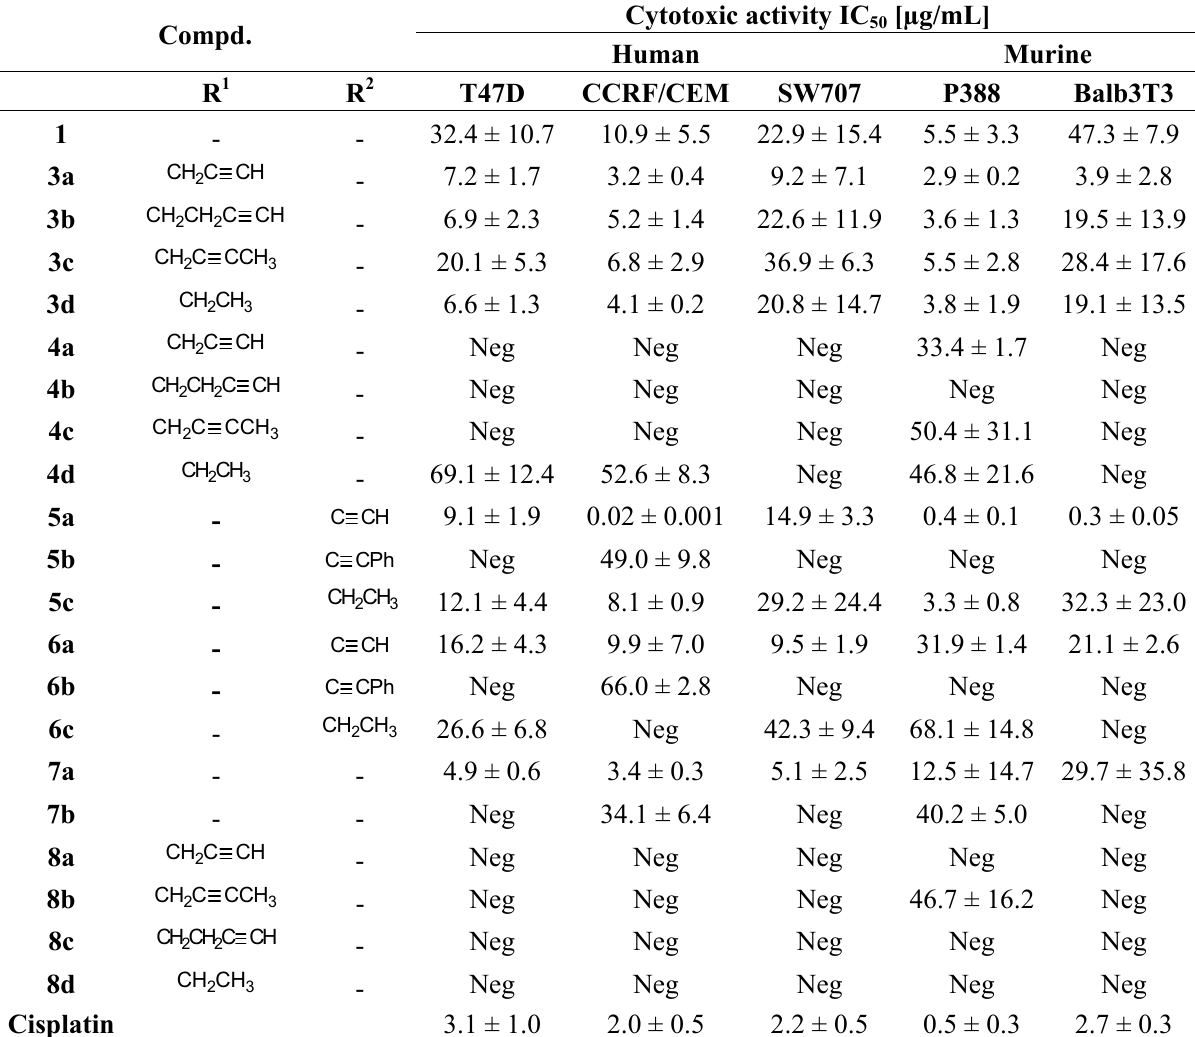
Neg – negative in the concentration